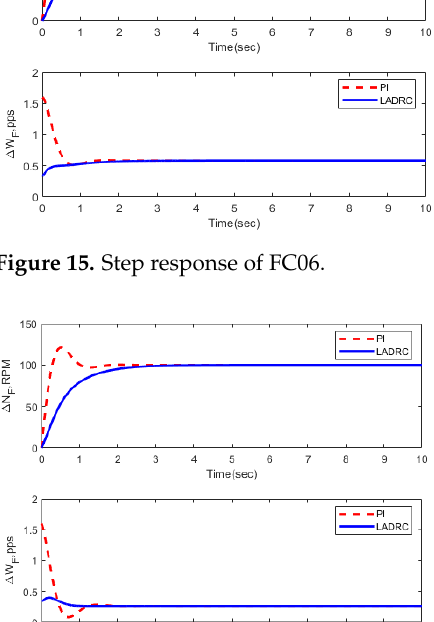
12 of 18 Figure 12. Step response of FC03. Figure 13. Step response of FC04.